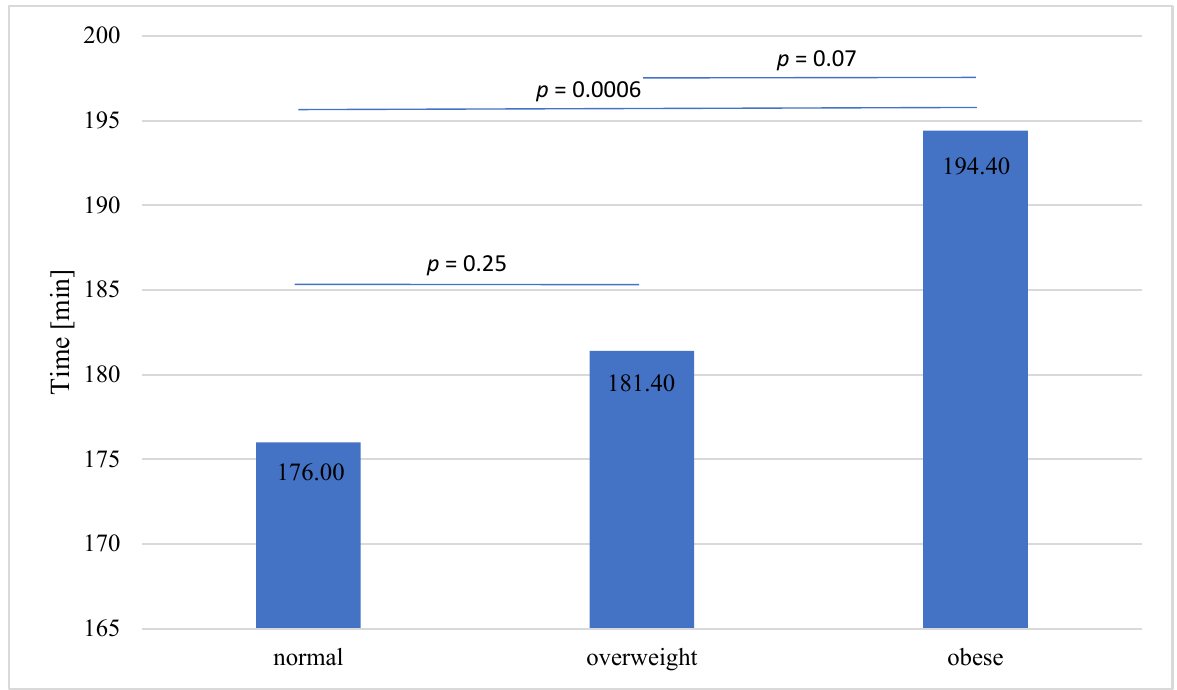
Figure 1. Total procedure time in BMI stratified groups. Cold ischemia time (CIT) did not differ between the groups, whereas warm ischemia time (WIT) was significantly longer in the patients with obesity (Figure 2). The mean